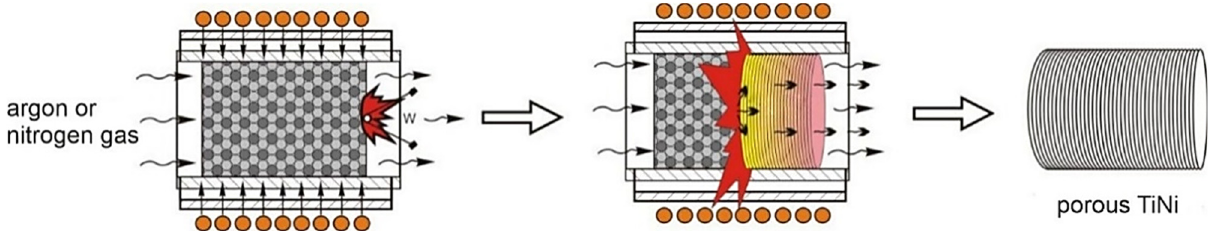
Figure 1. SHS scheme in a flow reactor for obtaining porous NiTi alloy.